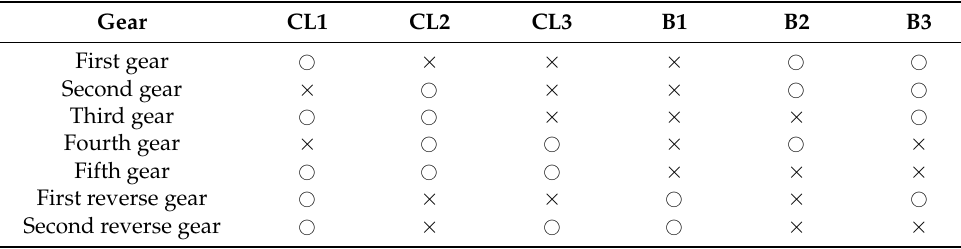
Table 2. The state table of control components for all gears